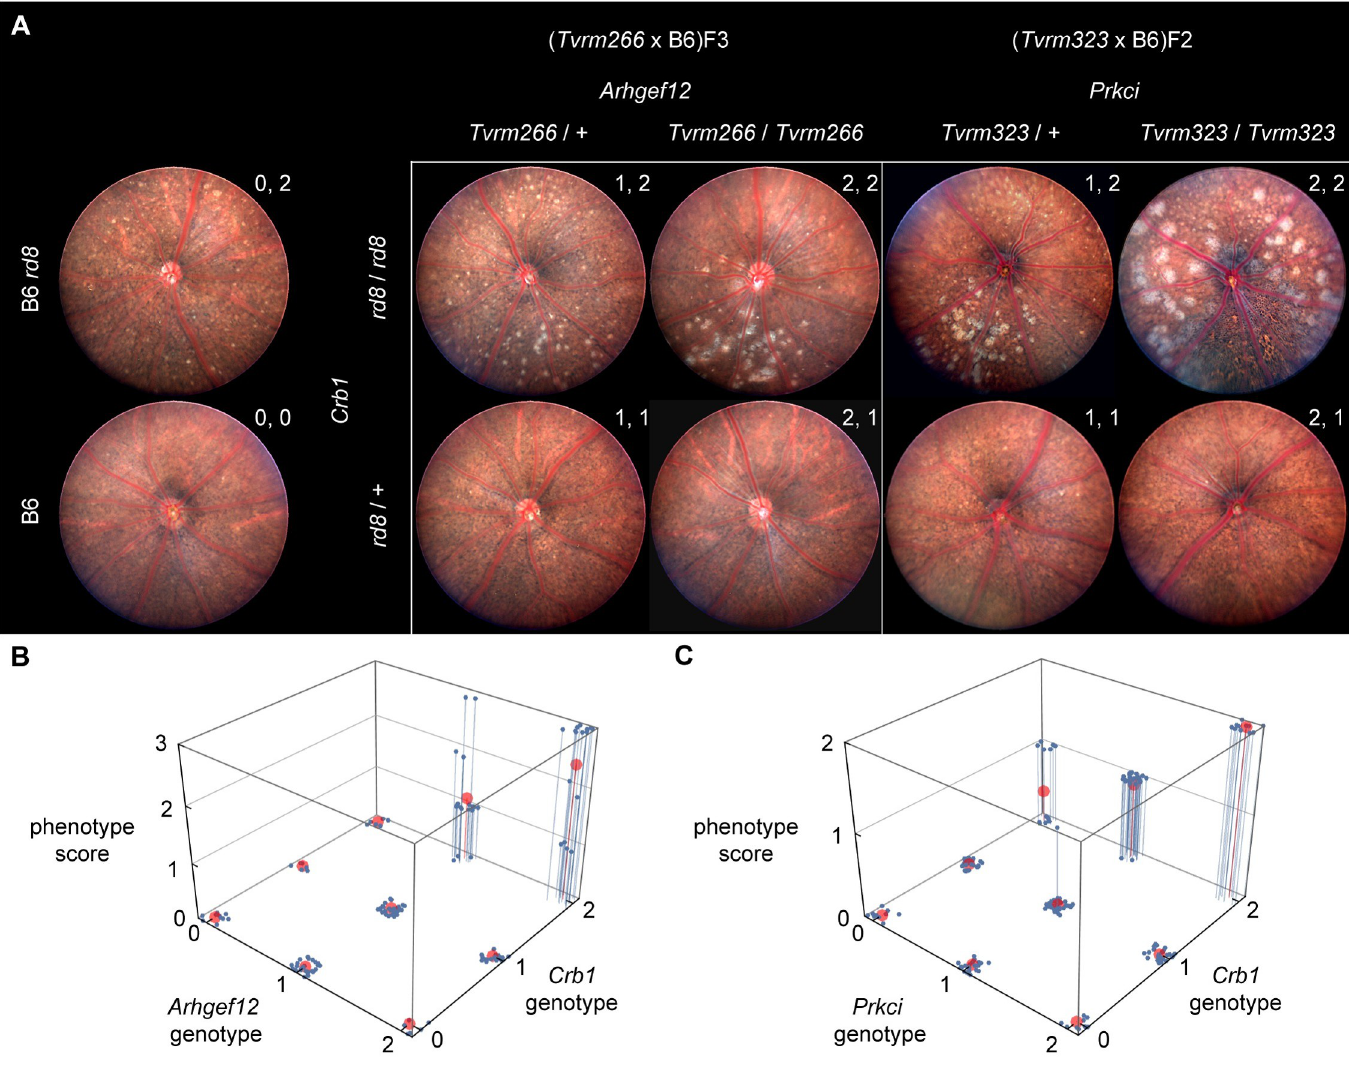
Fig 3. A. Fundus photographs of B6, B6 rd8 , and F 3 progeny from the Tvrm266 epistasis cross at 10 weeks of age or F 2 progeny from the Tvrm323 epistasis cross at 2.5–3.7 months of age. Genotypes are indicated by m/+ (heterozygous) or m/m (homozygous), where m is the mutant allele symbol and, for comparison with panels B and C, by the values a, b at the upper right of each fundus image, which indicate the number of mutant alleles at the modifier and Crb1 loci, respectively (0, wild-type; 1, heterozygous; 2, homozygous). At least 3 females and 3 males of each genotype were imaged bilaterally. B. 3D plot of the indirect ophthalmoscopy phenotypes of F 2 and F 3 progeny from the Tvrm266 epistasis cross (9–15 weeks of age) against the nine genotypes expected (n = 6–21 for each genotype). C. Corresponding plot of F 2 phenotypes from the Tvrm323 epistasis cross (2.5–3.7 months of age; n = 10–48 for each genotype). Indirect ophthalmoscopy annotations were converted to ordinal phenotype scores. Scores for individual mice of each genotype examined are shown in blue , with fit statistical models represented by red circles . Genotypes values are indicated as in panel